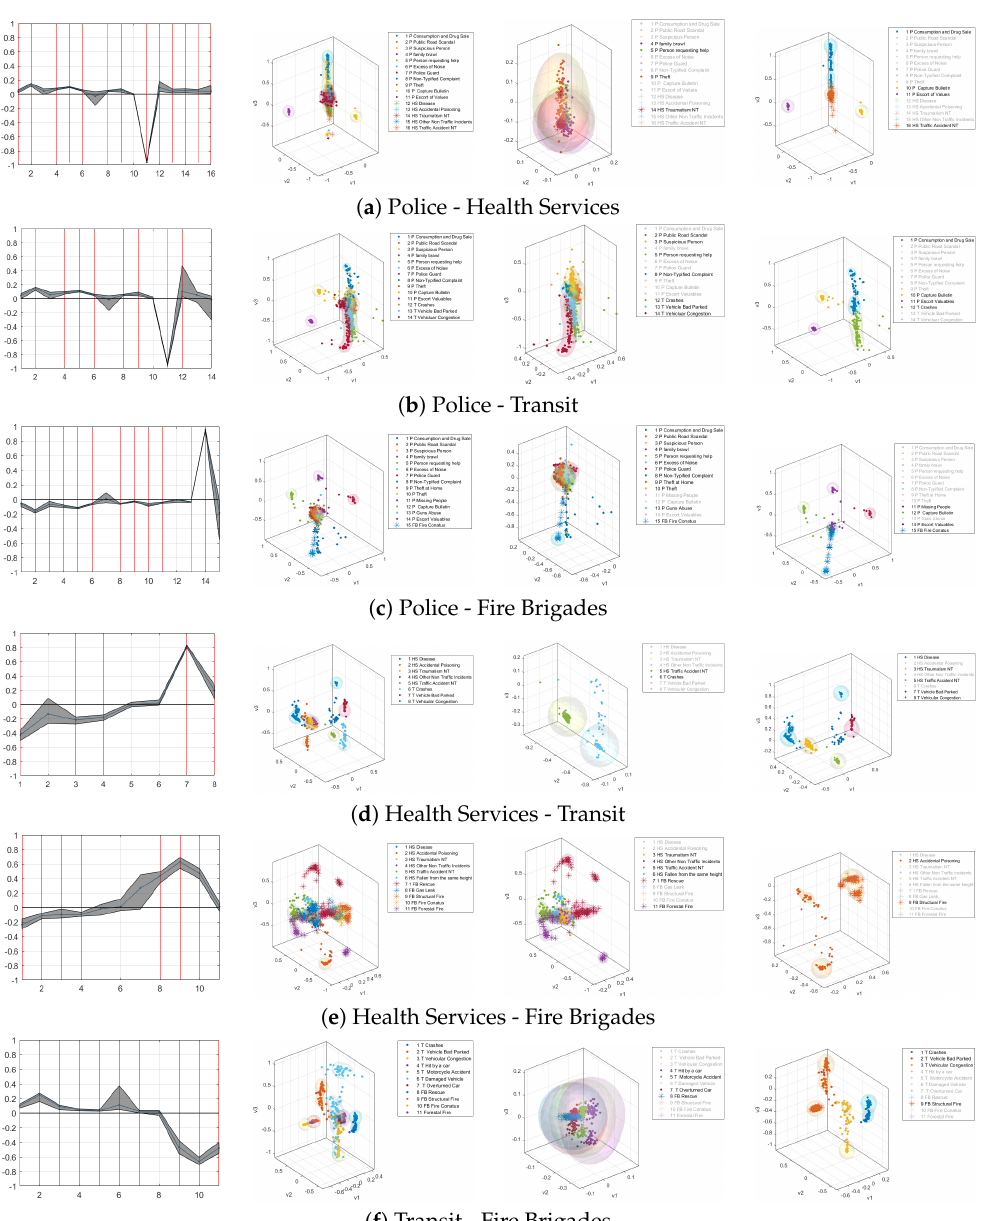
Figure 8. MCA results of paired combinations for fire brigades, police, health service, and transit. Each row shows the first eigenvector, a general 3D plot, a 3D plot of the related categories, and a 3D pot of the unrelated categories (eigenvalue plot is